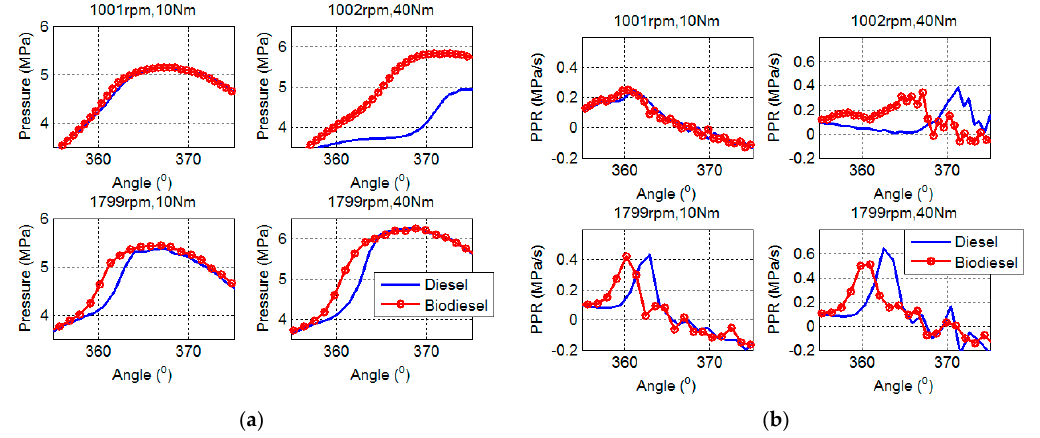
Figure 8. In-cylinder pressure curves and pressure rise rates: ( a ) Measured in-cylinder pressure; ( b ) Rise rate of in-cylinder pressure.